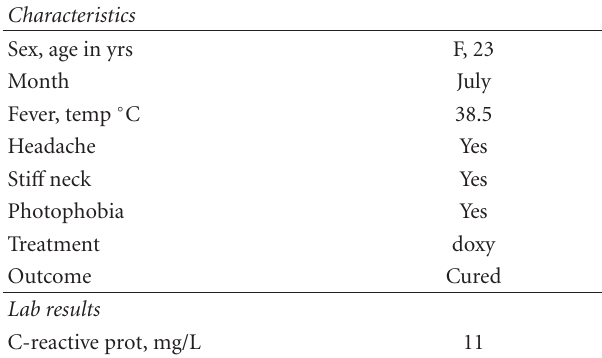
Table 1: Summary of the disease history and laboratory